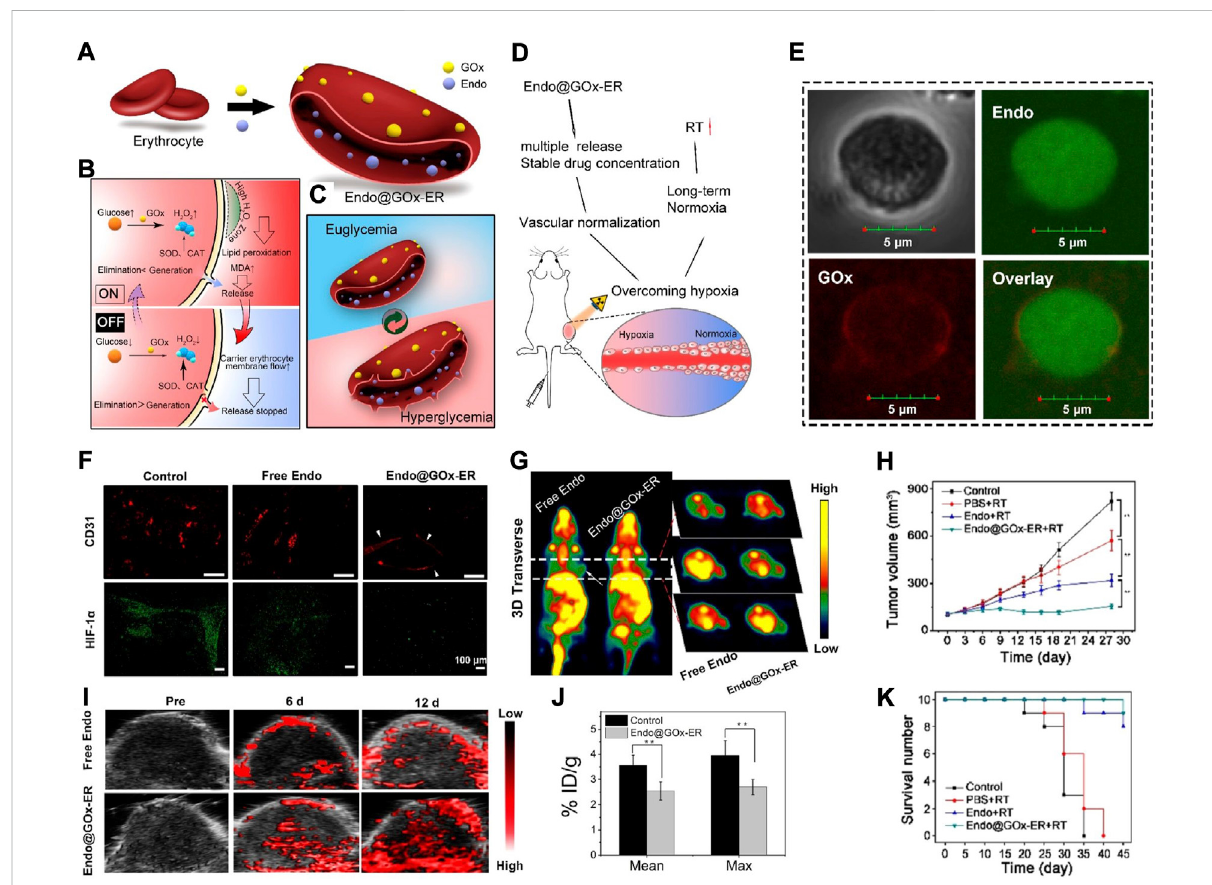
FIGURE 4 (A) TheschemeshowingthesynthesisofEndo@GOx-ER. (B,C) Theschemedisplayingglucose-mediatedreleaseofEndofromEndo@GOx-ER. (D) The scheme representing the released Endo is capable of promoting tumor vascular normalization, reversing tumor hypoxia, and improving therapeutic outcomes of RT. (E) Confocal images demonstrating the encasement of Endo by biotin-GOx. The scale bar is 5 μ m. (F) Immuno fl uorescence analysis oftumor sectionsstained with CD31 andHIF-1 α .The scale baris100 μ m. (G) RepresentativePA imagesshowing the ratio of oxygenated hemoglobin to deoxygenated hemoglobin in tumors after indicated treatments. (H) Representative micro-PET scan images showing the absorption of 18 F-MISO in tumors after indicated treatments. (I) % ID/g of 18 F-MISO after indicated treatments. (J,K) Tumor volume (J) and survival number (K) of mice after indicated treatments. Reprocessed with permission from ref 59. Copyright 2020, American Chemical